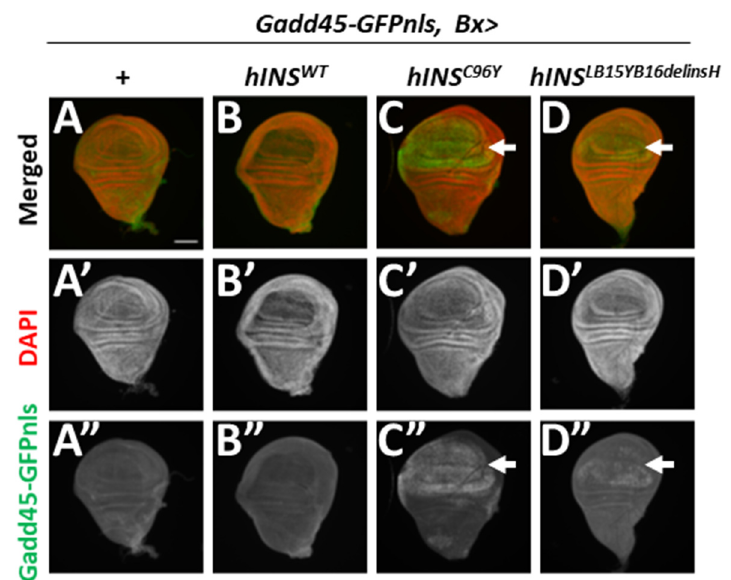
Figure 3. The ectopic expression of human mutant preproinsulin, hINS C96Y , and hINS LB15YB16delinsH induced Gadd45 transcription in wing imaginal discs. ( A , B ) GFP fluorescence (green in ( A , B ), white in ( A ”– D ”), arrow in ( C , C ”) and ( D , D ”)) indicating Gadd45 expression in wing imaginal discs. Red in A – D : DNA staining (white in A ’– D ’). ( A – A ”) A control wing disc ( Bx-Gal4/+; Gadd45-GFP/+ ). ( B – B ”) A wing disc expressing hINS WT in the wing pouch region ( Gadd45-GFP, Bx > hINS WT ). ( C – C ”) A wing disc expressing hINS C96Y ( Gadd45-GFP, Bx > hINS C96Y ). ( D – D ”) A wing disc expressing hINS LB15YB16delinsH ( Gadd45-GFP, Bx > hINS LB15YB16delinsH ). Scale bar: 100 μ m.